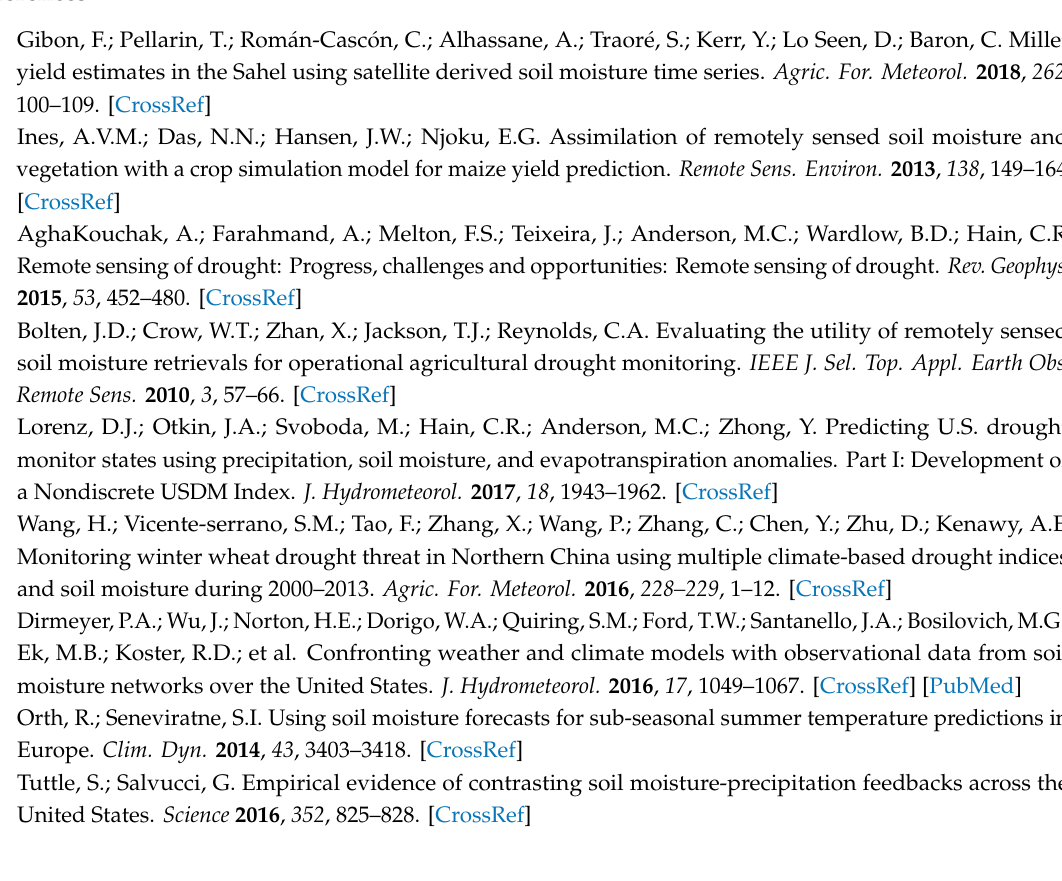
Figure S1: Digital elevation model at 0.5 m resolution (a), clay and sand percentages at 30 m resolution (b and c, respectively) of the study area. Sensor locations are also shown, Figure S2: Violin plots showing the distribution of the static variables considered over the study area. Blue dots represent the values of such variables at the sensor locations, Figure S3: Maps showing crops grown within individual fields over the study area for 2018 (a) and 2019